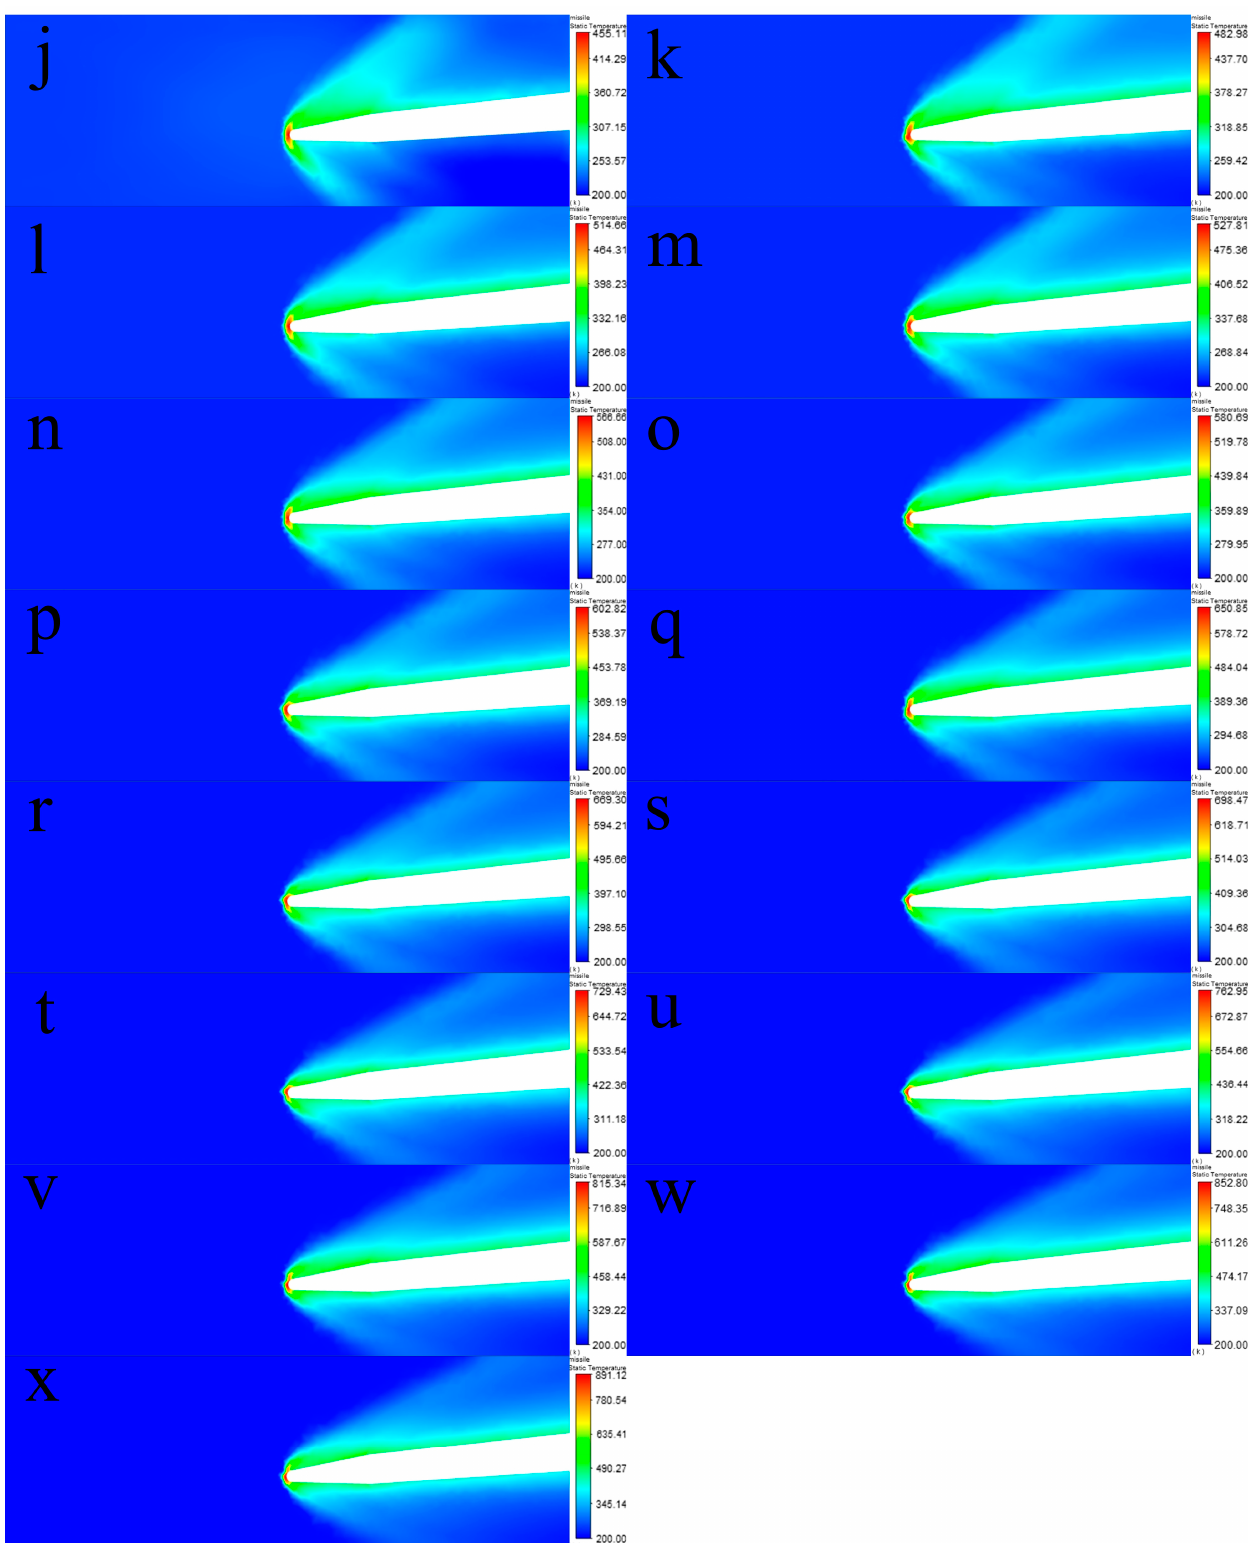
Figure 4. The contours of groups ( a – i ) with attack angle 0°.